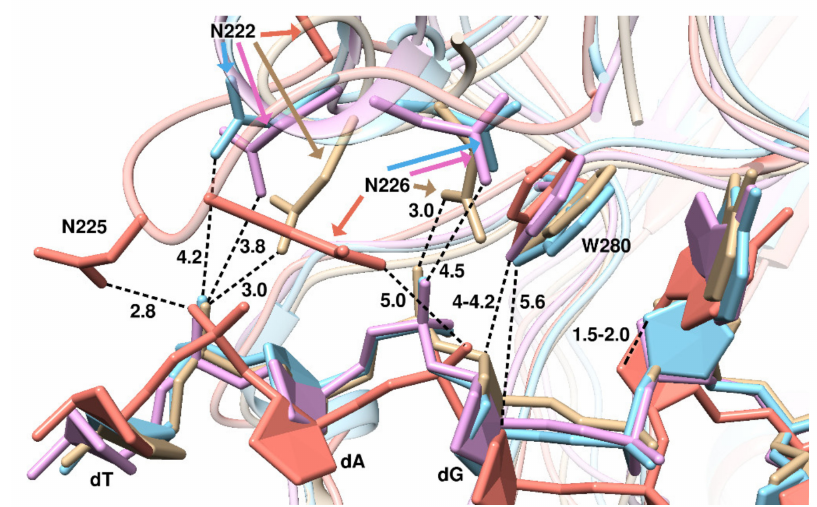
Figure 8. The position of α A, and the structure of the Asn222–Ala230 loop in different models (hAPE1 is sand-colored, zAPE1 is cyan, xAPE1 is magenta, and Rrp1 is red). To demonstrate the shift of the DNA backbone in the complex with Rrp1 relative to the others, the distance between two α A C2 (cid:48) atoms of the models involving zAPE1 and Rrp1 is shown (1.5–2.0 Å), as are the distances between hAPE1 Trp280 N ε 1 and C3 (cid:48) atoms of dG in the models involving hAPE1 (4.0–4.2 Å) and Rrp1 (5.6